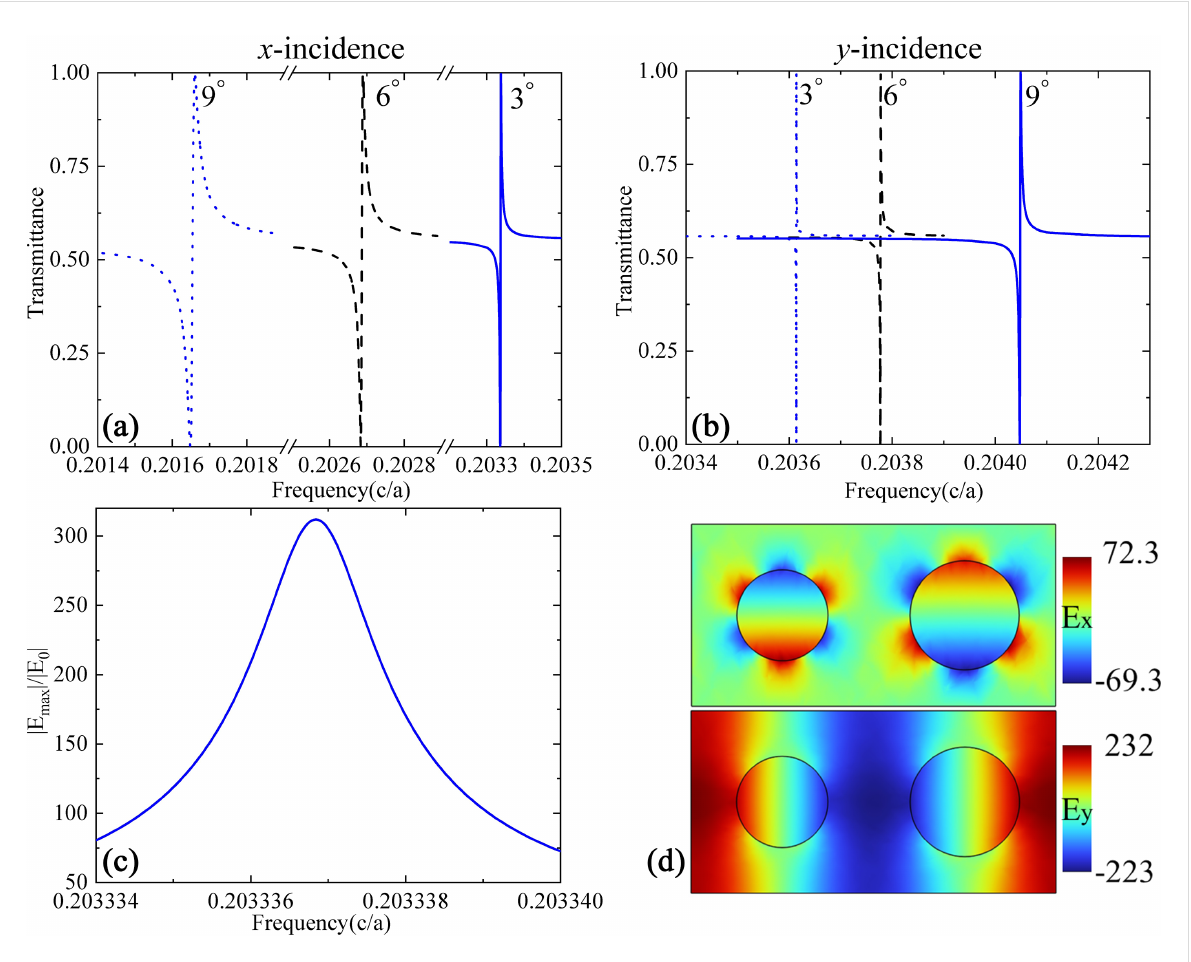
Figure 4: Transmission spectra at different incident angles with the incidence in (a) the xz plane and (b) the yz plane. (c) The maximum electric field magnitude normalized to that of the incident wave across the central plane of the Si layer. (d) Typical distributions of E x and E y along the central plane of the silicon